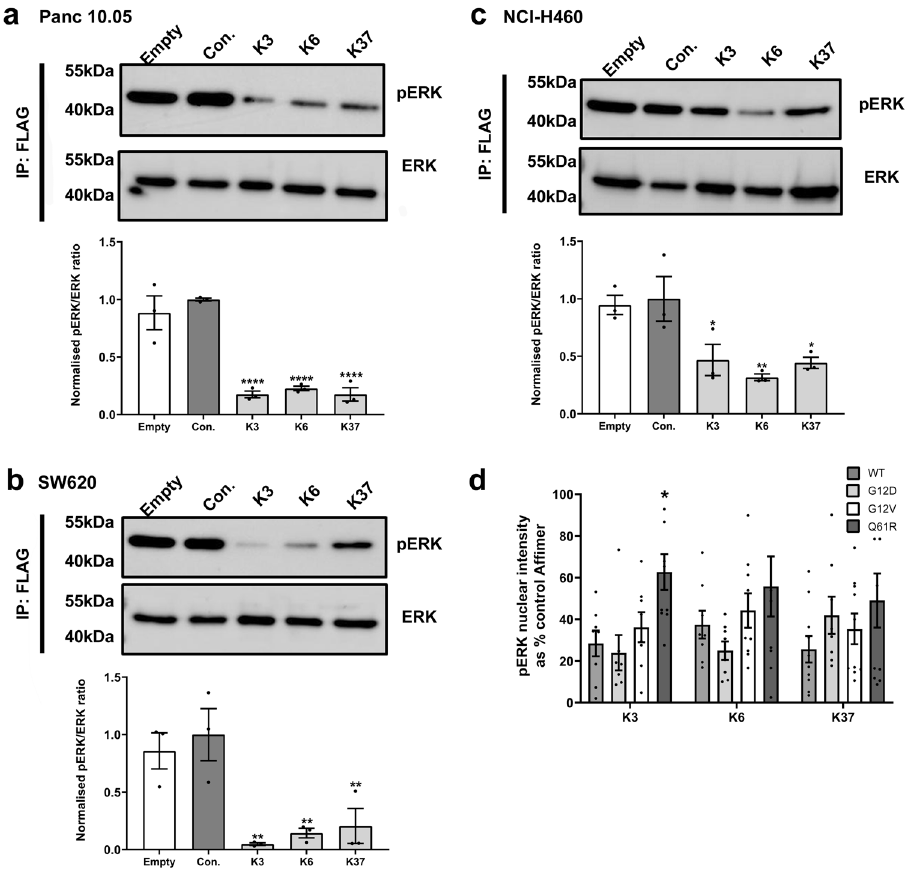
Fig. 3 RAS-binding Af fi mers show different mutant speci fi cities. a Panc 10.05 (KRAS G12D ), ( b ) SW620 (KRAS G12V ), and ( c ) NCI-H460 (KRAS Q61H ) cells were co-transfected with FLAG-ERK1 plasmid and pCMV6 encoding tGFP tagged Af fi mers. Twenty-four hours post transfection cells were serum-starved for 1 h. FLAG-ERK1 was precipitated from cell lysates using anti-FLAG beads and analyzed for phosphorylation by immunoblotting with anti-ERK and anti- phospho-ERK antibodies. Representative blots are shown together with quanti fi cation graphs. All three RAS-binding Af fi mers, K3, K6, and K37, inhibit ERK phosphorylation in Panc 10.05 cells ( a ) One-way ANOVA with Dunnett ’ s post-hoc test compared to control Af fi mer, **** p < 0.0001) and SW620 cells ( b ) One-way ANOVA with Dunnett ’ s post-hoc test compared to control Af fi mer **p = 0.0026 K3, p = 0.0054 K6, and p = 0.0088 K37). The magnitude of inhibition by Af fi mers K3 and K37 is reduced in NCI-H460 cells ( c ) One-way ANOVA with Dunnett ’ s post-hoc test compared to control Af fi mer *p = 0.0269 K3, **p = 0.0062 K6, *p = 0.0210 K37). d RAS-binding Af fi mers inhibit EGF-induced phosphorylation and nuclear translocation of endogenous ERK in mouse embryonic fi broblasts (MEFs) expressing single human KRAS mutants (G12D, G12V, Q61R) as measured by immuno fl uorescence as a percentage of the control Af fi mer. Only Af fi mer K3 shows weaker inhibition in the Q61R expressing cell line (Two-way ANOVA with Tukey ’ s post-hoc compared to KRAS WT for each Af fi mer * p = 0.0221. Data are mean ± SEM, n = 3 independent experiments for all cell lines. Con. Control Af fi mer (Variable regions of AAAA and AAE), EGF epidermal growth factor, tGFP turbo green fl uorescent protein, IP immunoprecipitation, Empty transfection reagents only, WT wild